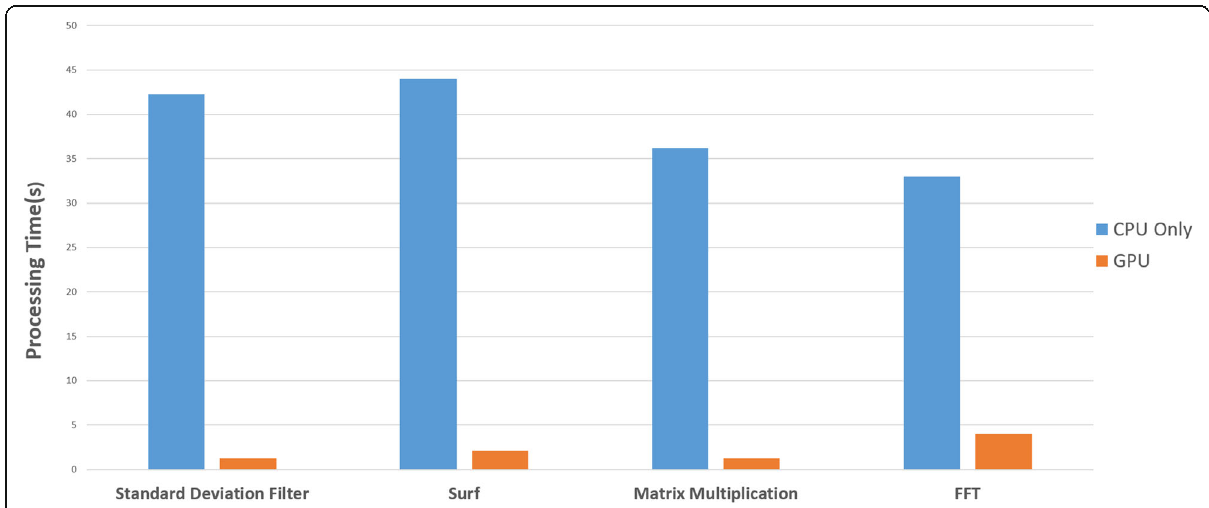
Fig. 9 Comparison of parallelizing performance on two modes of